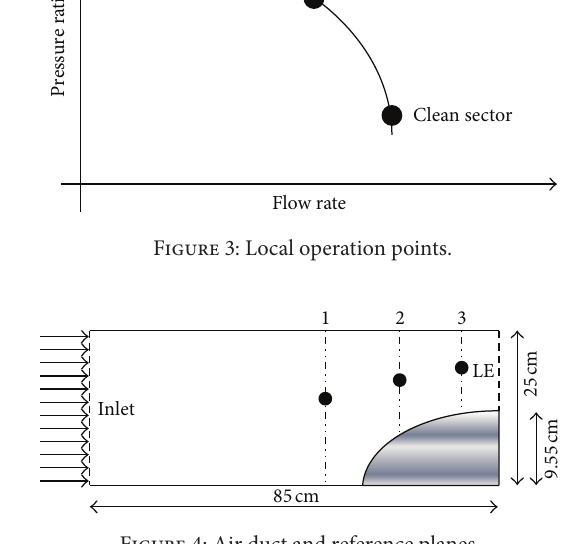
Figure 4: Air duct and reference planes.